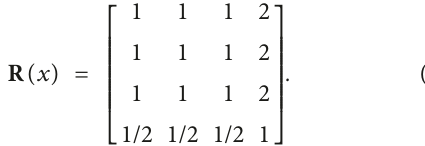
Table 1: PV estimates derived from R ( x ) with application of the particular AP and two characteristics of PV estimates quality in relation to the genuine PV for the case.